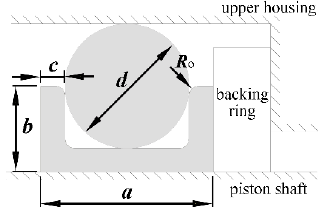
Figure 5. Schematic of the Cap-seal.